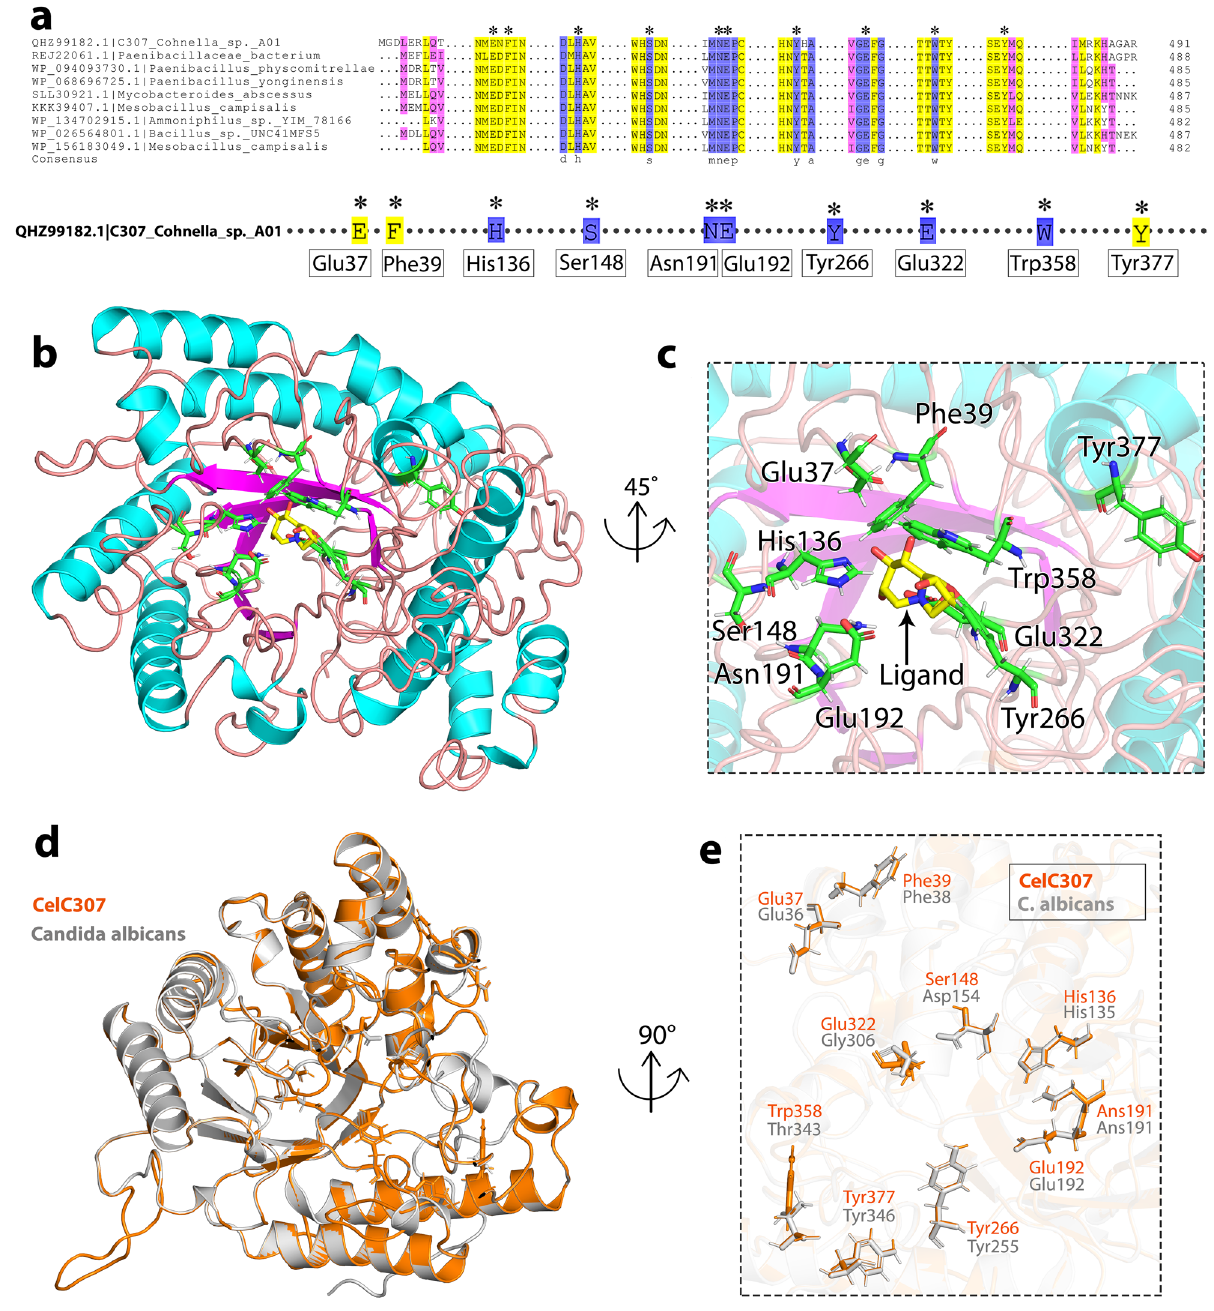
Figure 3. In silico structural characterization, and homology modeling of CelC307. ( a ) Multiple sequence alignments of CelC307 with cellulases from other genera and with the maximum of similarity. The blue shading indicates conserved identical residues. Yellow and pink shading indicates substitution with strongly and weakly similar residues, respectively. The predicted residues of the active site are star-marked. Sequence alignments were performed and visualized with DNAMAN software. ( b ) PyMOL V.2.3.4. pictured the CelC307 predicted protein model. The purple and blue structures are beta-sheet and alpha-helix, respectively. ( c ) PyMOL V.2.3.4. pictured the predicted active site structure in CelC307 protein. The amino acids colored in green are the residues in the active site interacting directly with the ligands (shown in yellow) selected by COFACTOR. ( d ) The 3D superimposition between the native structure of cellulase from Candida albicans (gray) and the predicted CelC307 structure (copper). The active site amino acids are featured in the image. ( e ) Adaptation of the active site amino acids of CelC307 and Candida albicans after